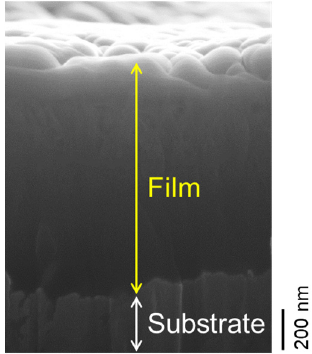
Figure 4. Cross ‐ sectional view of film prepared at 180 °C for 1 h.